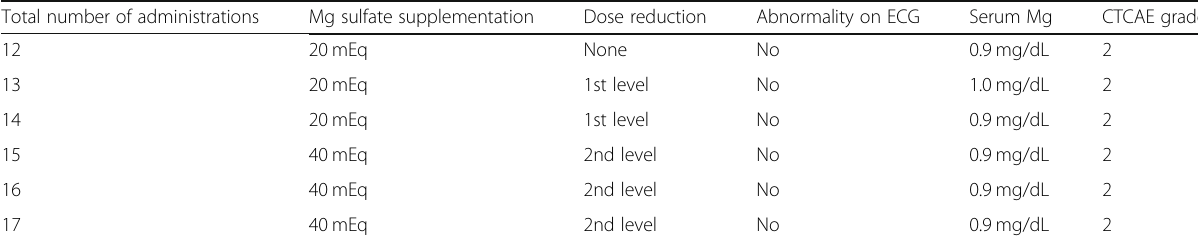
Table 1 Time course of serum magnesium level, ECG, level of dose reduction of chemotherapy, and supplementation of